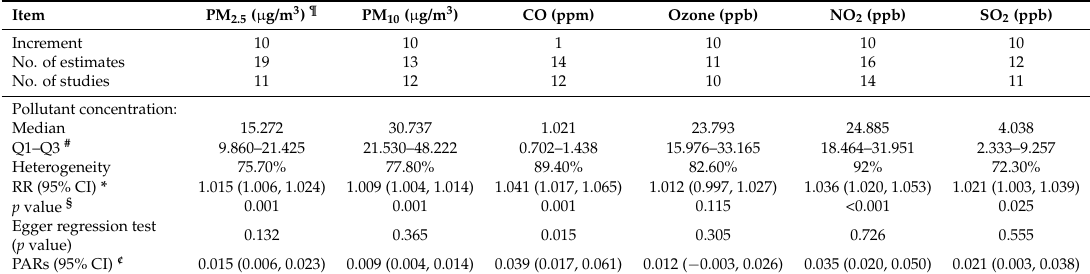
Table 3. Heterogeneity, publication bias and population attributable risks across air